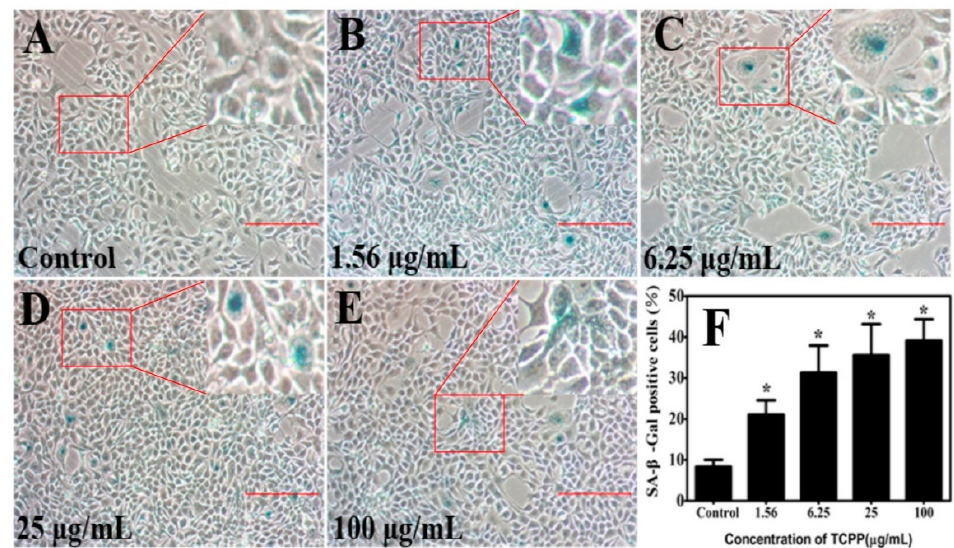
Figure 6. TCPP increased senescence markers (senescence-associated- β -galactosidase (SA- β -Gal) activity) in cultured HaCaT cells ( A – E ) after exposure to 1.56–100 µ g/mL TCPP for 24 h ( A – E ), and the percentage of SA- β -Gal positive cells (blue color) was shown in ( F ). The senescence phenotype was seen as blue staining cells. 200× magnification. Scale bar 100 μ m. * p < 0.05.